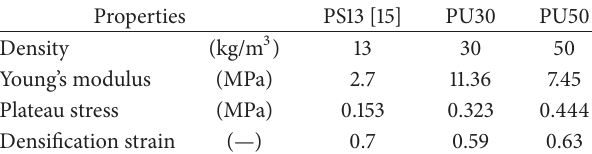
Table 2: Mechanical properties of the considered polymeric foams.